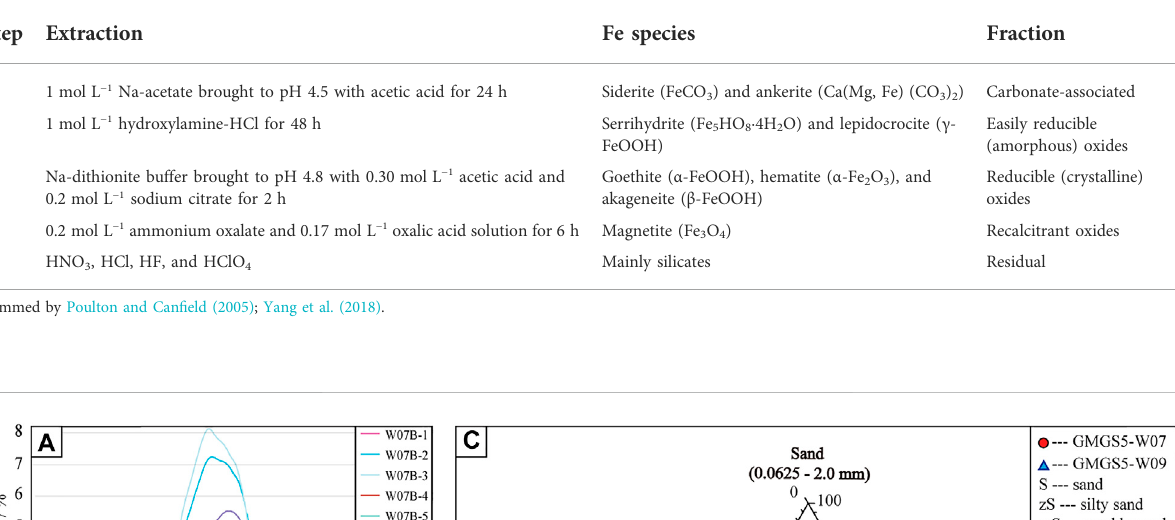
TABLE 2 Sequential extraction processes for studying the speciation of Fe in sediments.